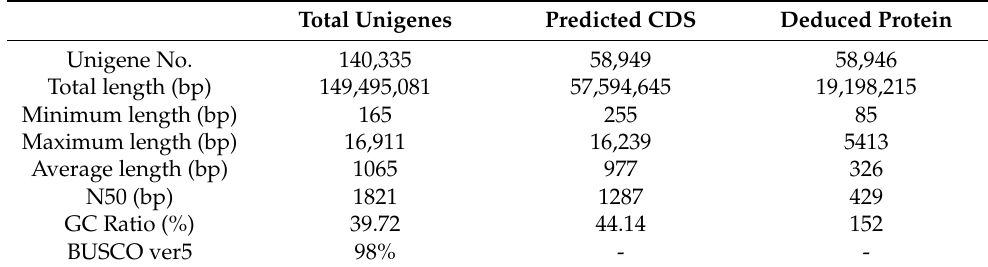
Table 1. Unigene set information generated from R. glutinosa . Total Unigenes Predicted CDS Deduced